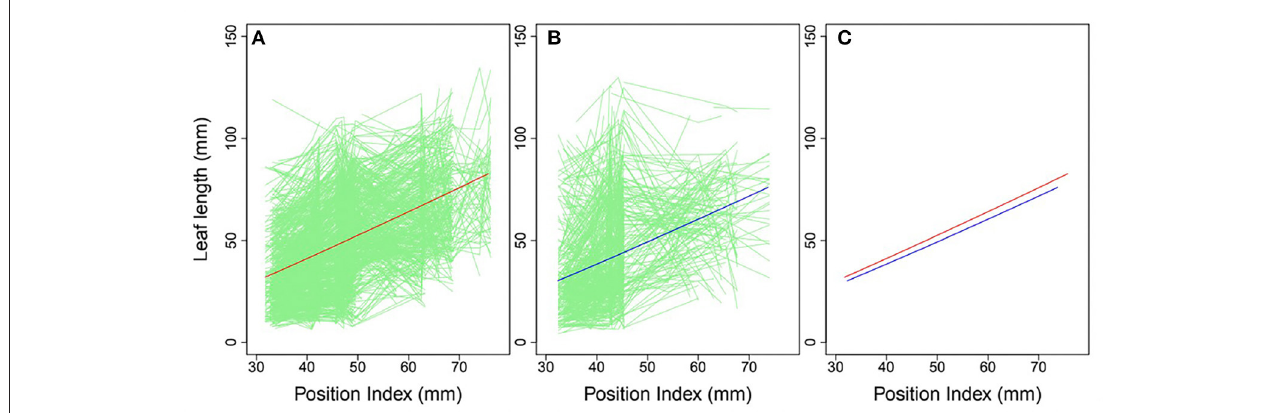
FIGURE 4 | Heterophylly curve of leaf length vs. position index. Green lines in (A,B) are individual heterophylly curves for the control and salt stress groups, and red and blue lines indicate their mean heterophylly curves. (C) Comparison of the two mean curves.